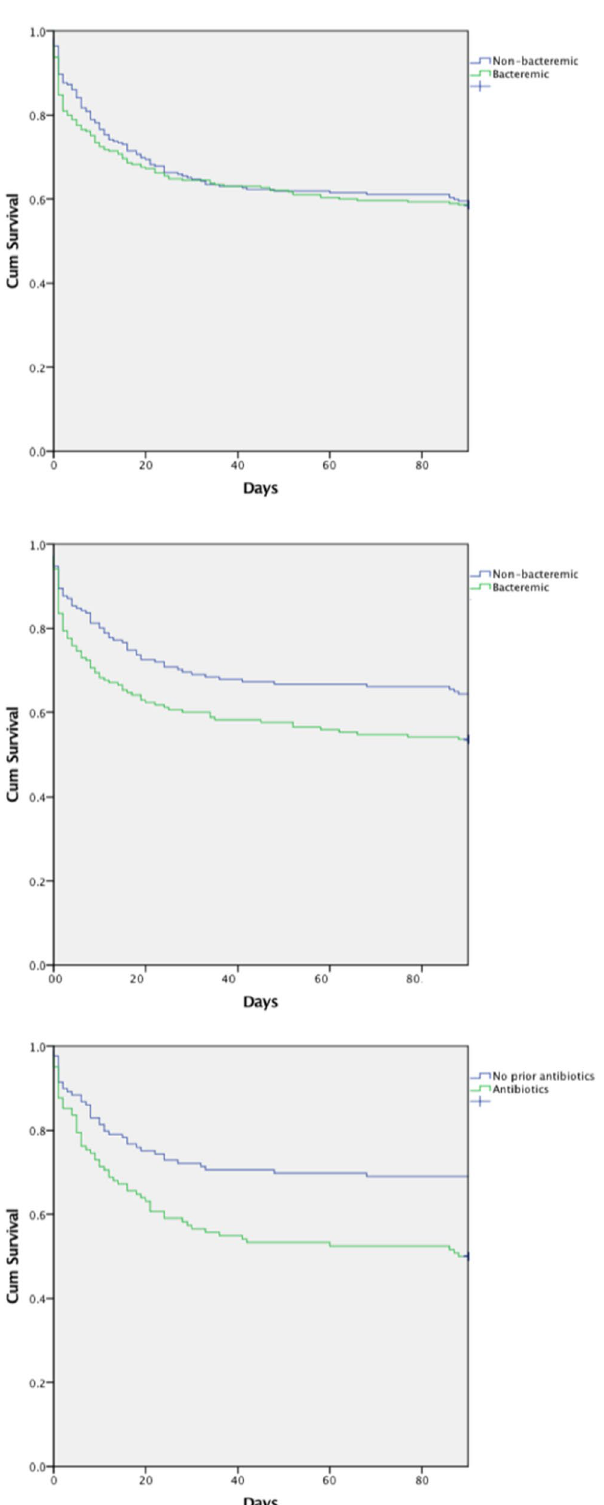
Figure 2. ( A ) 90-day mortality in bacteremic and non-bacteremic patients, non-adjusted cohort, showing no significant difference 42% versus 41%, p = 0.74. ( B ) 90-day mortality in bacteremic and non-bacteremic patients, propensity matched cohorts, showing a significant difference 47% versus 36% p = 0.04. ( C ) 90-day mortality in non-bacteremic patients with/without prior antibiotic therapy showing a significant difference 51% versus 31%, p <